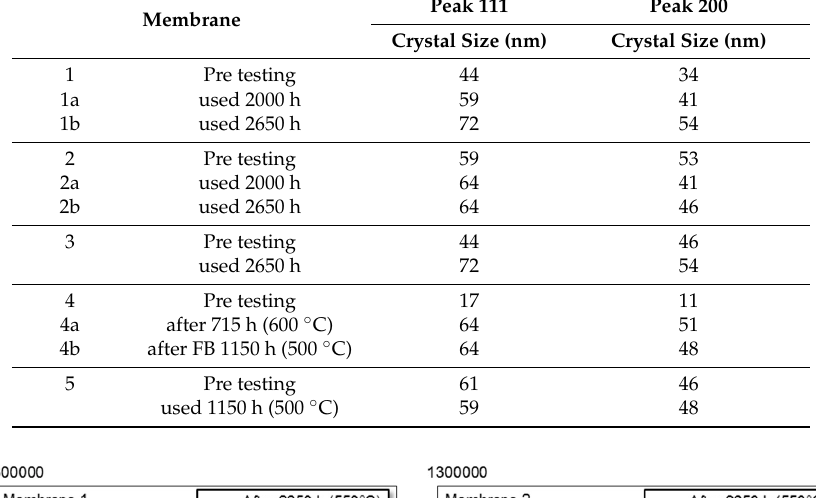
Table 4. Crystal sizes calculated from XRD results.